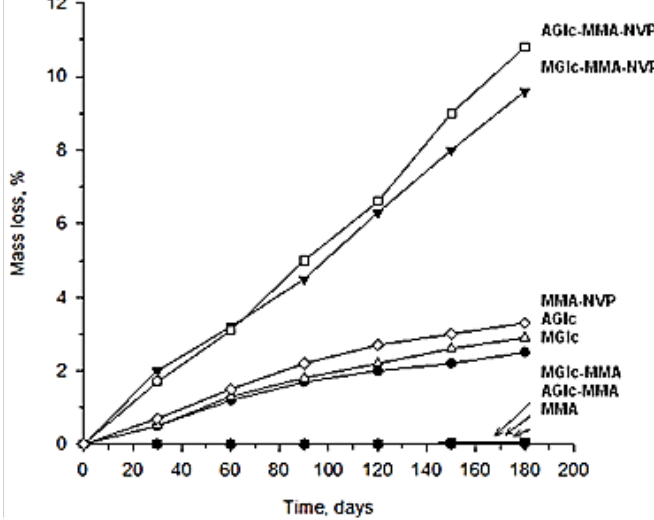
Figure 11. Results of biodegradation studies: mass loss (%) versus time (days).